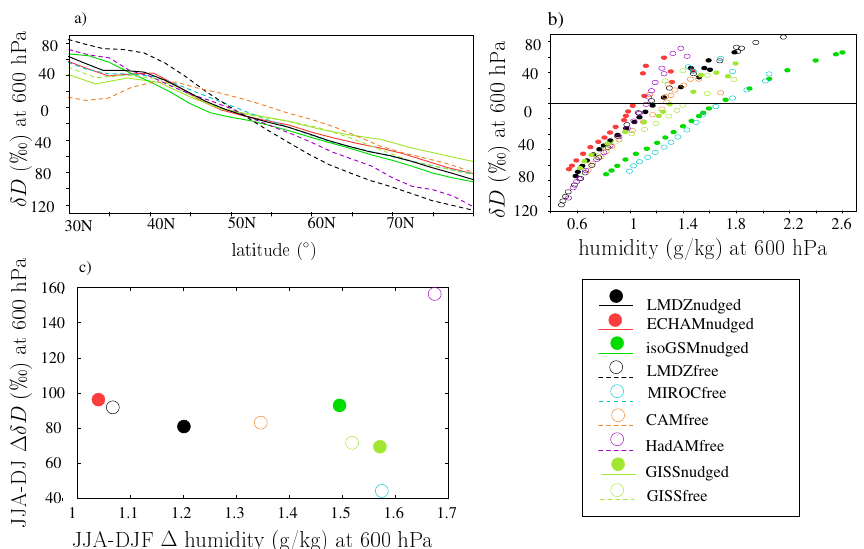
Figure 8. (a) Annual mean north–south transects of water vapor δD at 600hPa simulated by different SWING2 models. Transects are taken Fig. 8. (a) Annual mean north-south transects of water vapor δD at 600 hPa simulated by different SWING2 models. Transects are taken around the longitude of Kourovka: 50 ◦ E-70 ◦ E. The annual-mean around the longitude of Kourovka: 50–70 ◦ E. The annual-mean δD averaged over 50–70 ◦ E-30–80 ◦ N is subtracted to focus on the latitudinal δD averaged over 50 ◦ E-70 ◦ E-30 ◦ N-80 ◦ N is subtracted to focus on the latitudinal variations. The spatial variations. The spatial averaging are the same as in Fig. 3. (b) Water vapor δD D at 600hPa as a function of humidity at 600hPa. (c) Seasonal averaging are the same as in Fig. 3. (b) Water vapor δD D at 600 hPa as a function of humidity at 600 amplitudes (June–July–August minus December–January–February) of δD at 600 hPa in the region of Kourovka (50–64 ◦ N–50–70 ◦ E), as a hPa. (c) Seasonal amplitudes (June-July-August minus December-January-February) of δD at 600 hPa function of the seasonal amplitude in humidity at in the region of Kourovka (50 ◦ N-64 ◦ N-50 ◦ E-70 ◦ E), as a function of the seasonal amplitude in humidity at 600 hPa.